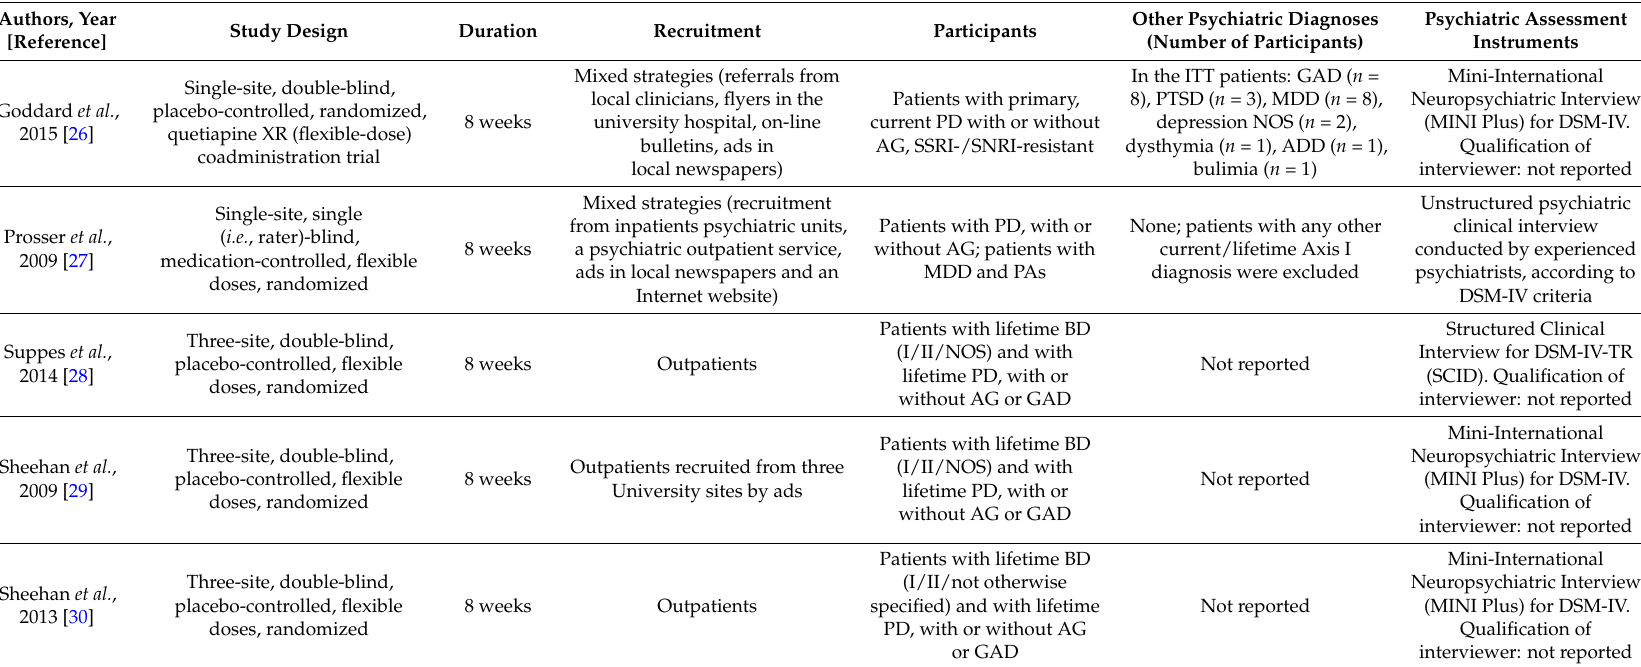
Table 1. Randomized controlled trials with second-generation antipsychotics in panic